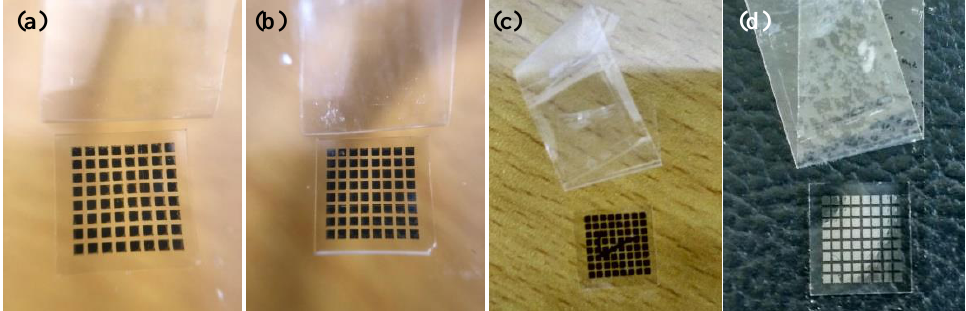
Figure 5. Photo of silver films based on NP ink after the tape test: ( a ) Heat cured in 80 °C for 30 min; ( b ) heat cured in 140 °C for 30 min; ( c ) UV cured at D = 37 cm for 180 s; ( d ) UV cured at D = 25 cm for 480 s.